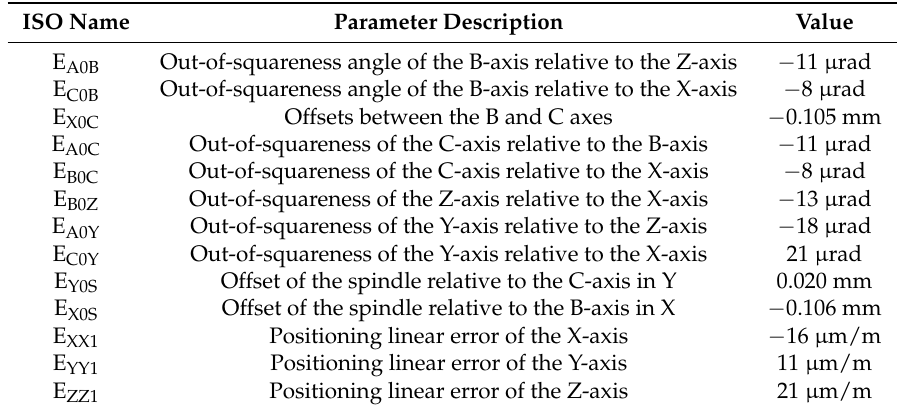
Table 2. Estimated error parameters for the 13-error model (nomenclature as per ISO230-1:2012).